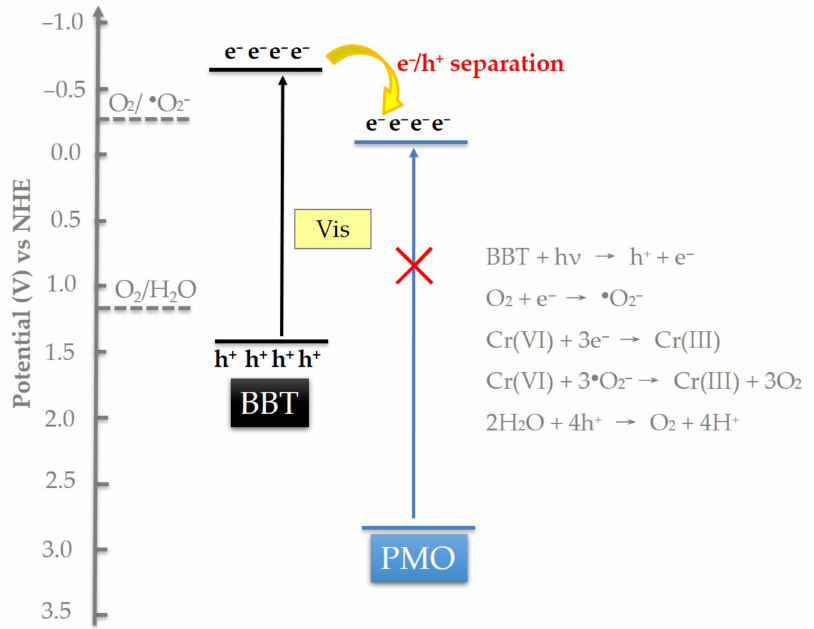
Figure 11. The possible reaction mechanism for Cr(VI) reduction over 13.3% BBT-PMO(M) and 16.7%